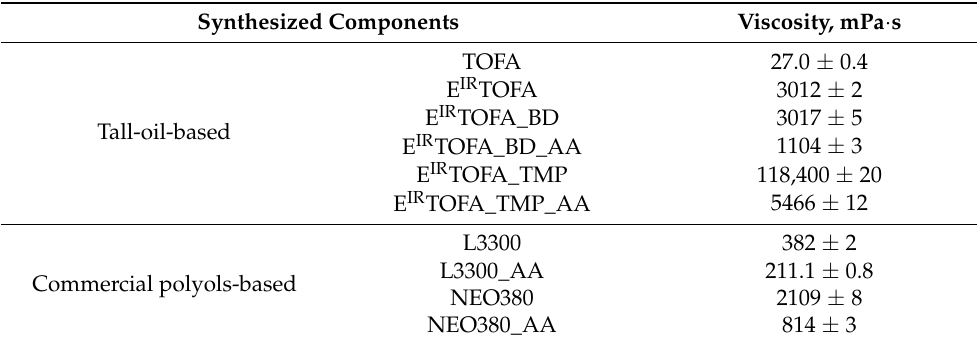
Table 2. The rheological viscosity of synthesized components for tall-oil-based polyols and their acetoacetates, and for commercial polyols and their acetoacetates at a temperature of 25 ◦ C. Synthesized Components Viscosity, mPa · s TOFA 27.0 ± 0.4 E IR TOFA 3012 ± 2 E IR TOFA_BD 3017 ± 5 Tall-oil-based E IR TOFA_BD_AA 1104 ± 3 E IR TOFA_TMP 118,400 ± 20 E IR TOFA_TMP_AA 5466 ± 12 L3300 382 ± 2 L3300_AA 211.1 ± 0.8 Commercial polyols-based NEO380 2109 ± 8 NEO380_AA 814 ±